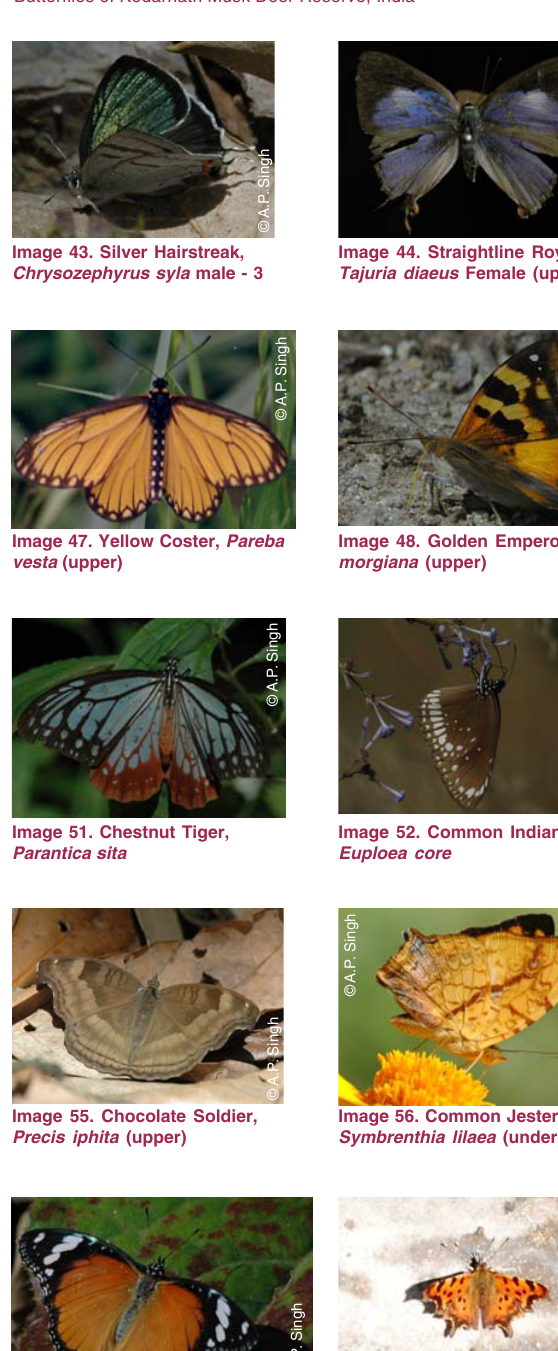
Image 59. Danaid Eggfly, Hypolimnas misippus (form inaria) (upper)